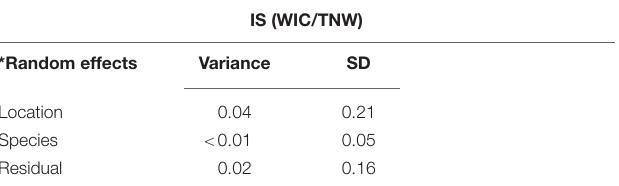
TABLE 1 | Differences in niche characteristics between